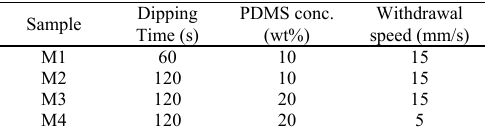
Table 1: Nomenclature of different fabricated PDMS/ceramic composite membranes.